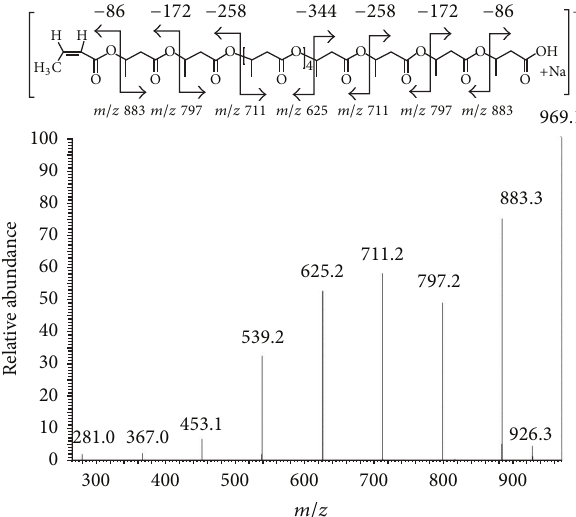
Figure 6: ESI-MS/MS product ion spectrum obtained for the selected sodium adduct of oligo(3-hydroxybutyrate) with crotonate and carboxyl end groups at m/z